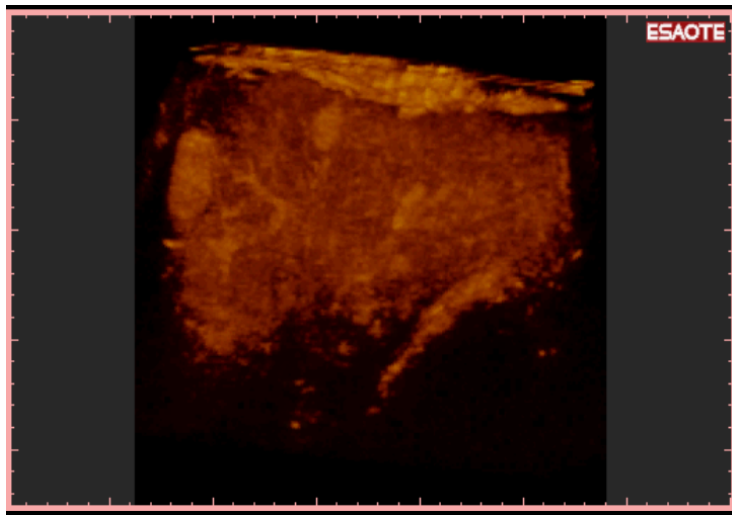
Figure 6. 3-D NAV CEUS reconstruction with vascular rendered volume of the